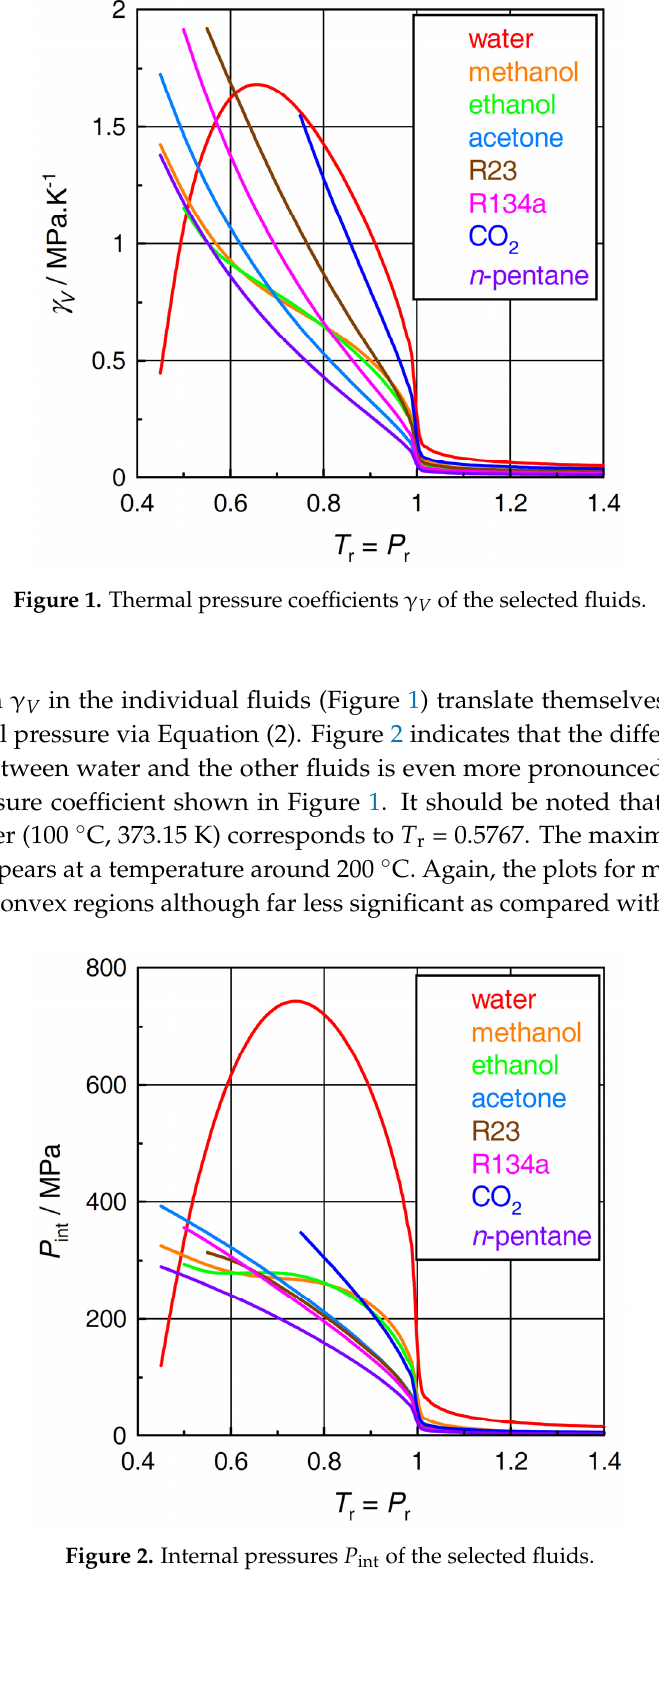
Figure 2. Internal pressures P int of the selected fluids.